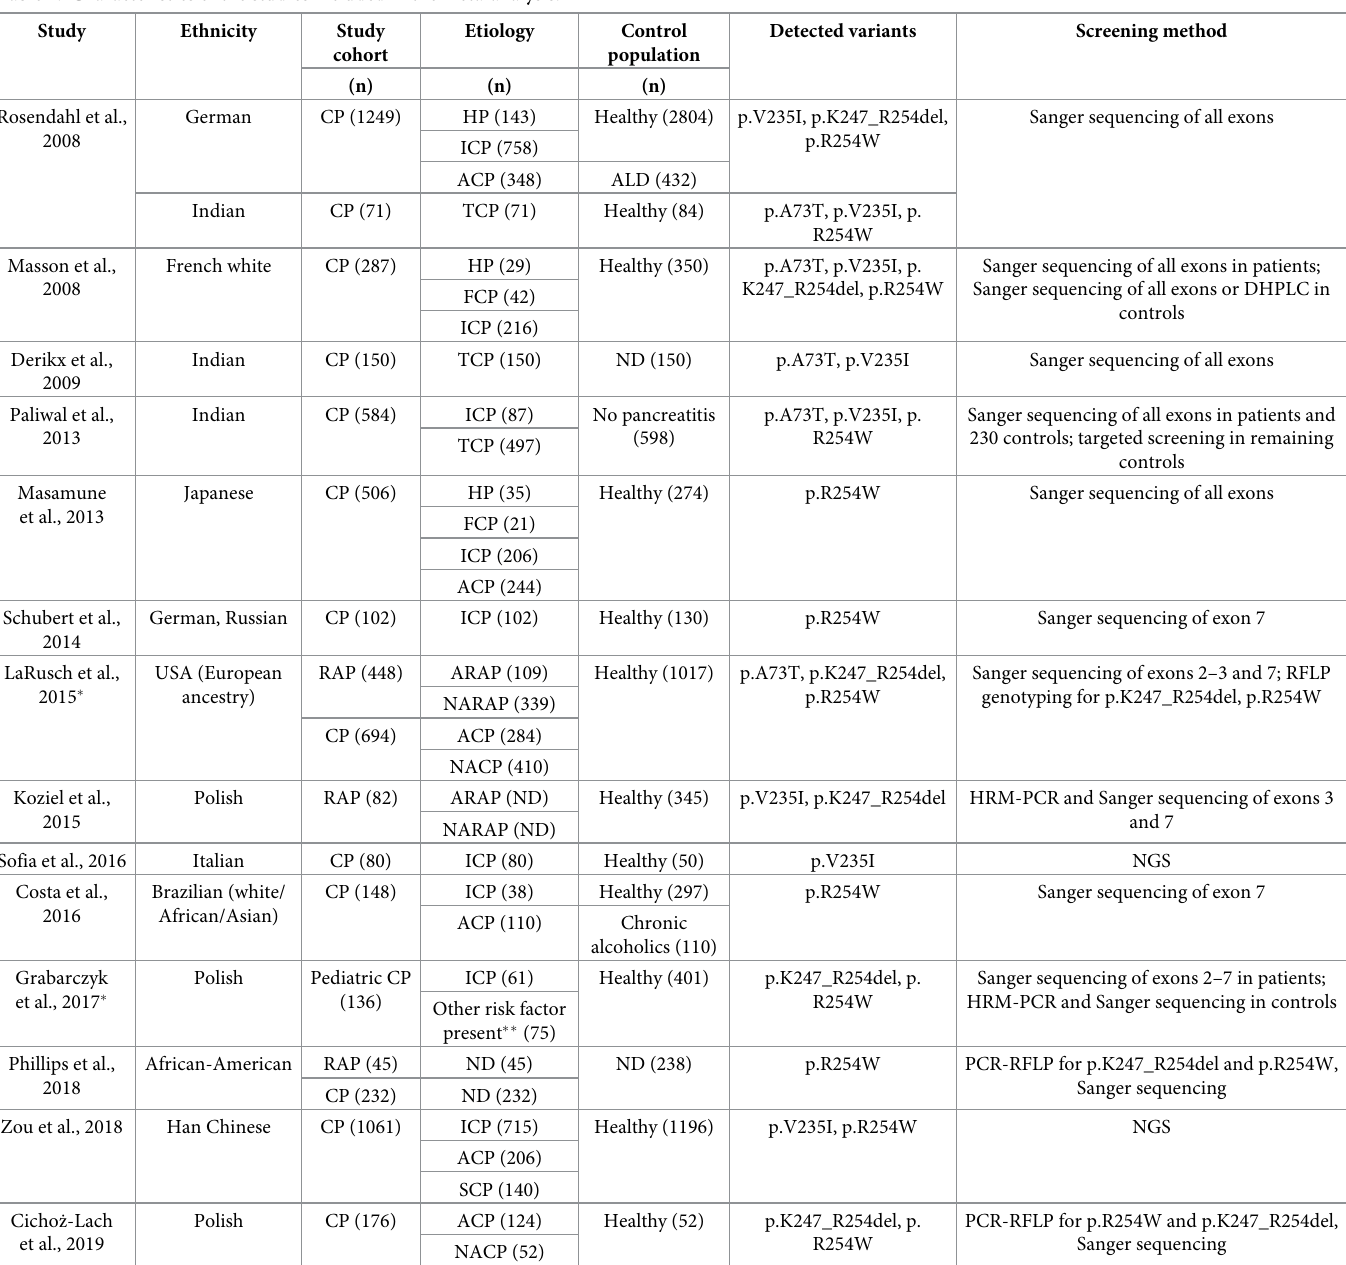
Table 1. Characteristics of the studies included in the